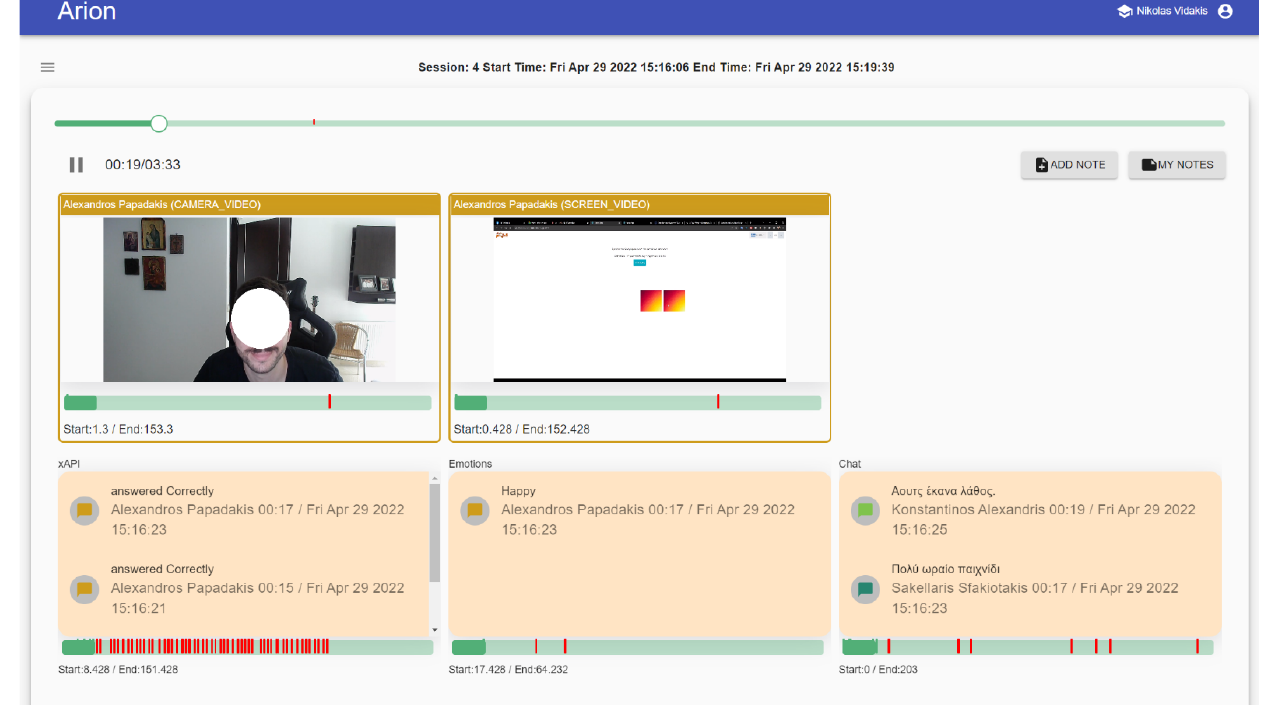
Figure 8. Open Studio with all the possible modalities.